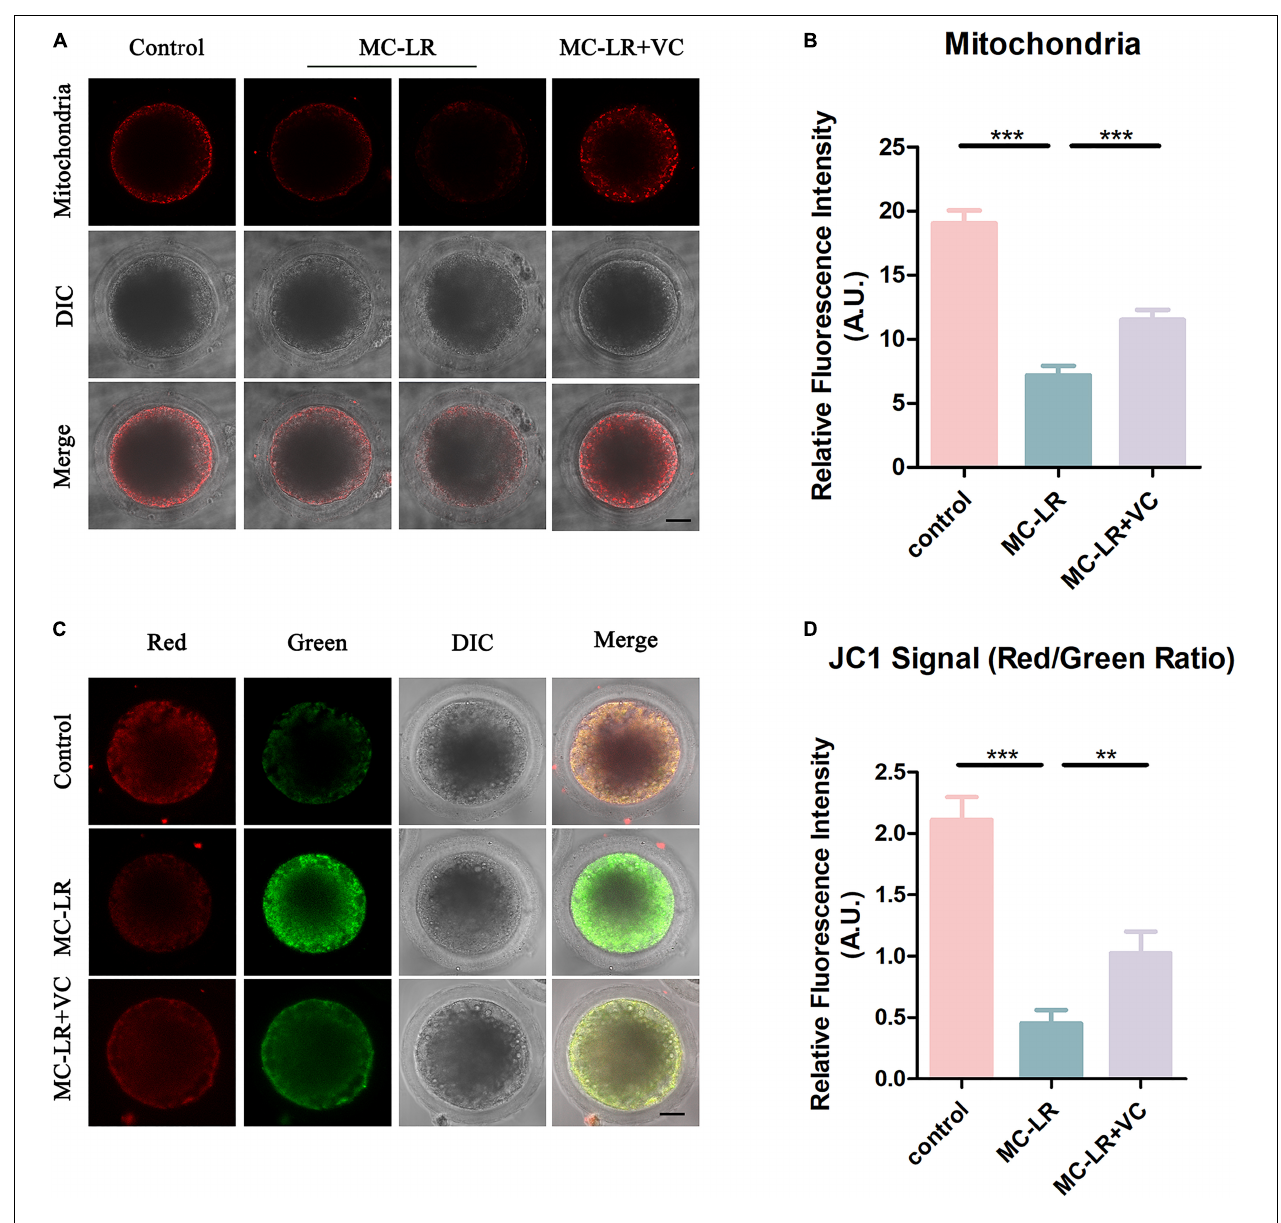
FIGURE 5 | VC protects MC-LR-exposed oocytes from mitochondrial damage. (A) Representative images of mitochondria distribution in the control, MC-LR-exposed, and VC-rescued groups. Bar = 20 µ m. (B) Quantitative analysis of the fluorescence intensity of mitochondria. (C) Mitochondrial membrane potential ( (cid:49)(cid:57) m) was detected by JC-1 in control, MC-LR-exposed, and VC-rescued groups (Red, high (cid:49)(cid:57) m; Green, low (cid:49)(cid:57) m). Bar = 20 µ m. (D) The ratio of red and green fluorescence intensity was recorded in control, MC-LR-exposed, and VC-rescued groups. ** p < 0.01, *** p < 0.001.